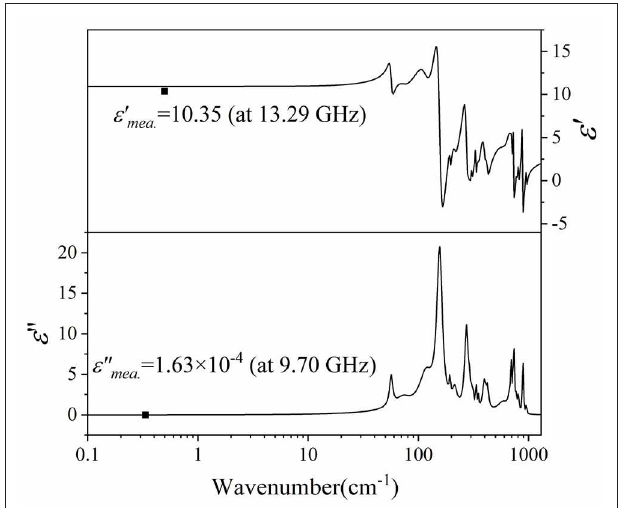
FIGURE 12 | The real and imaginary parts of the complex permittivity for Ce